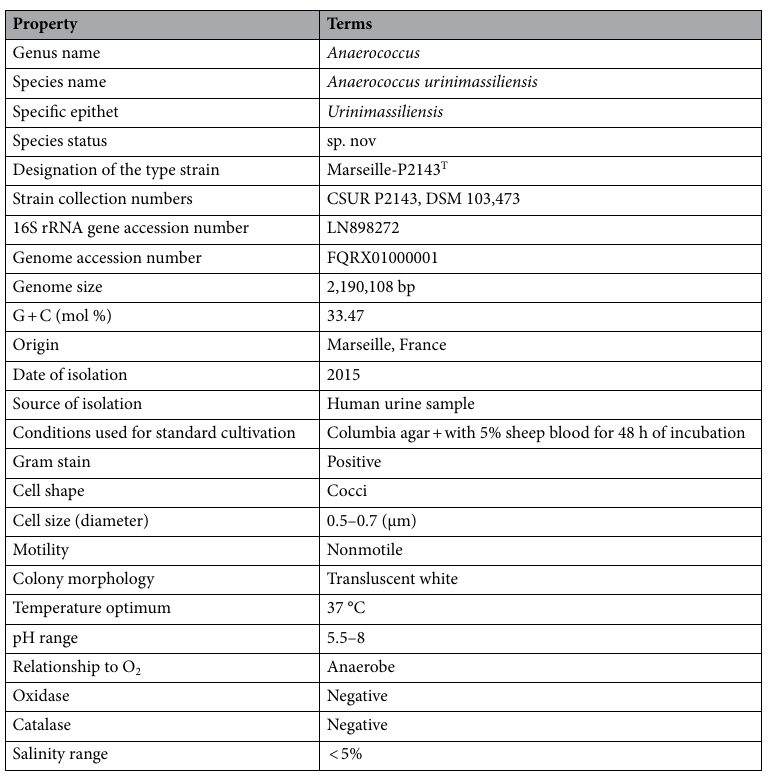
Table 1. Description and characteristics of Anaerococcus urinimassiliensis Marseille-P2143 T